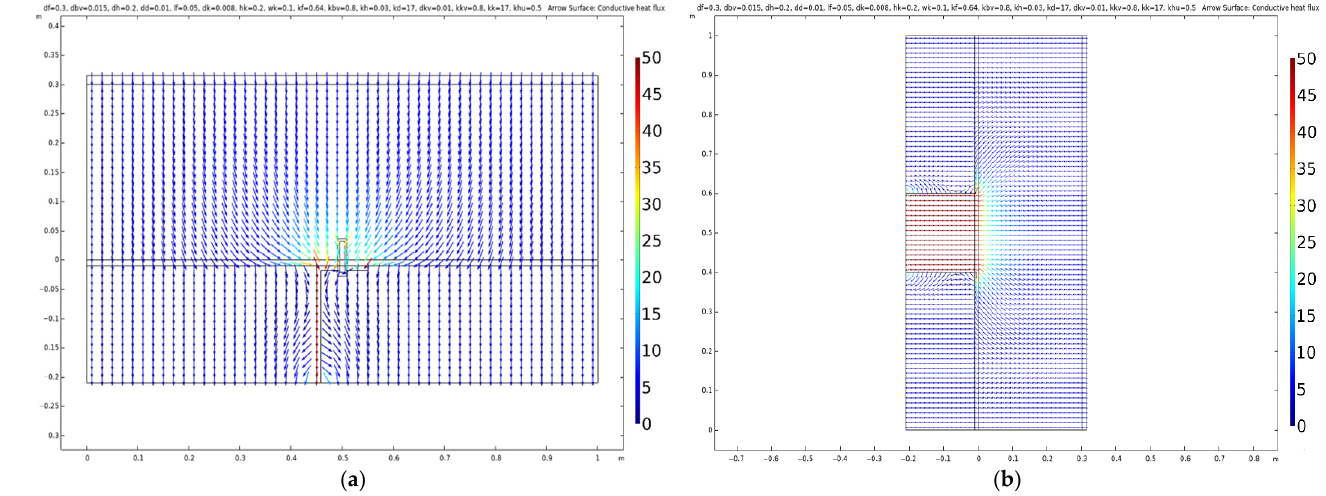
Figure 6. Heat flux vectors around the brackets in the vertical ( a ) and horizontal ( b ) section.